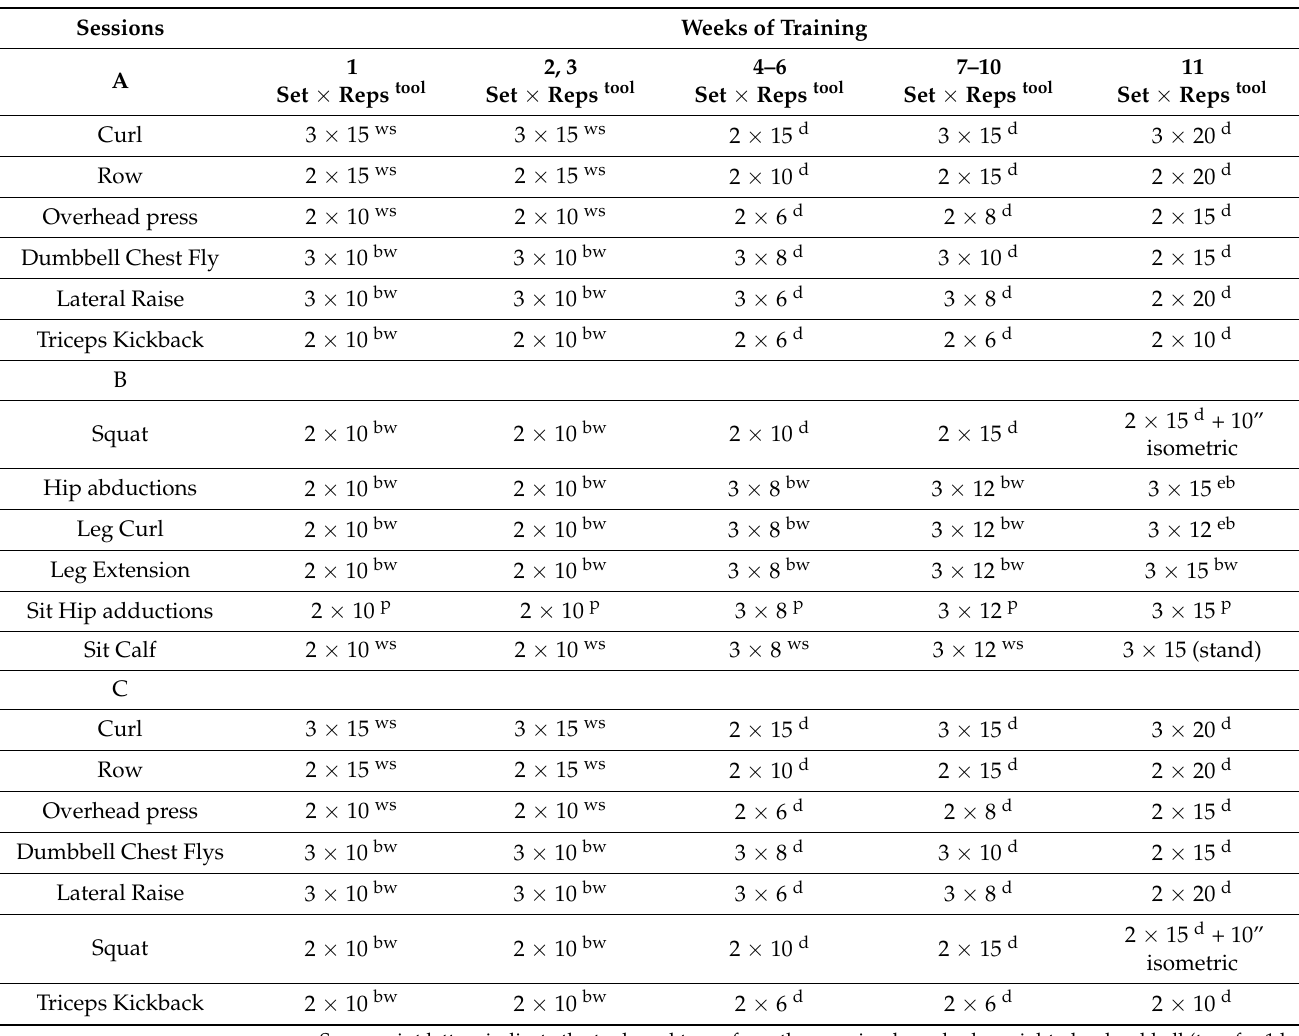
Table 1. Training sessions (A, B, and C) exercises and progressions.